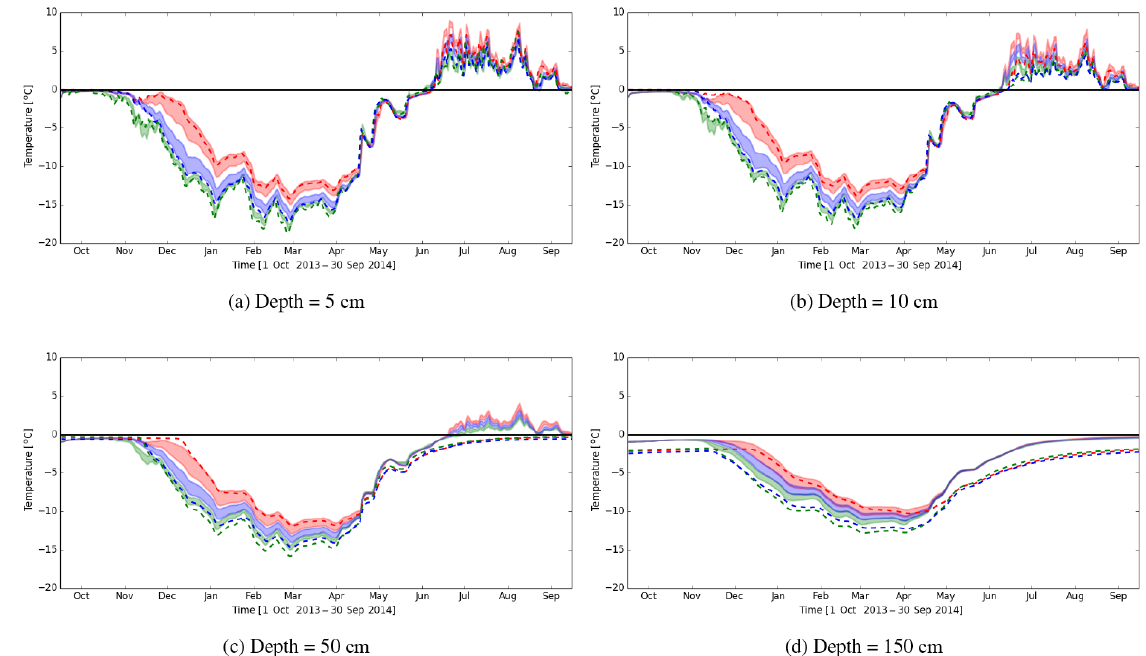
Figure 7. Simulated vs. observed soil temperatures at Site A at depths 5, 10, 50 and 150cm show bias in the model in deeper soil and during the warm summer season. Dotted lines represent observed data at center (in red), rim (green) and trough (blue) locations, while shaded curves show mean ± standard deviation of simulated daily soil temperatures across the